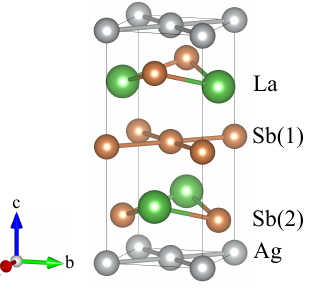
Figure 1. The tetragonal crystal structure of LaAgSb 2